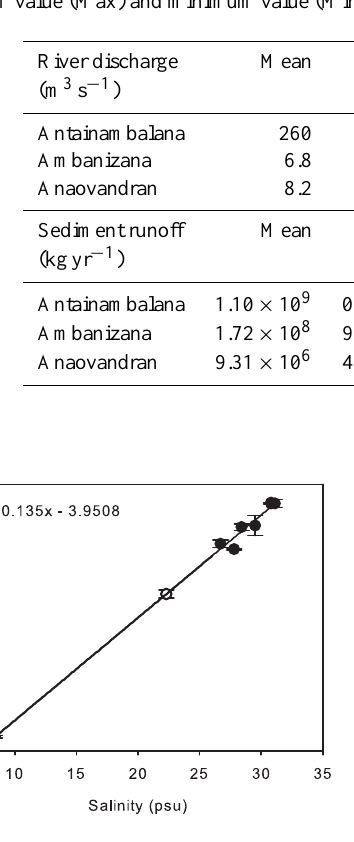
Fig. 7. Calibration of the δ 18 O of water samples with salinity mea- surements used to reconstruct salinity from coral δ 18 O sw . All data points are given as averages of two samples taken during the dry season (solid circles) and wet season (open circle). The standard deviation is given as error